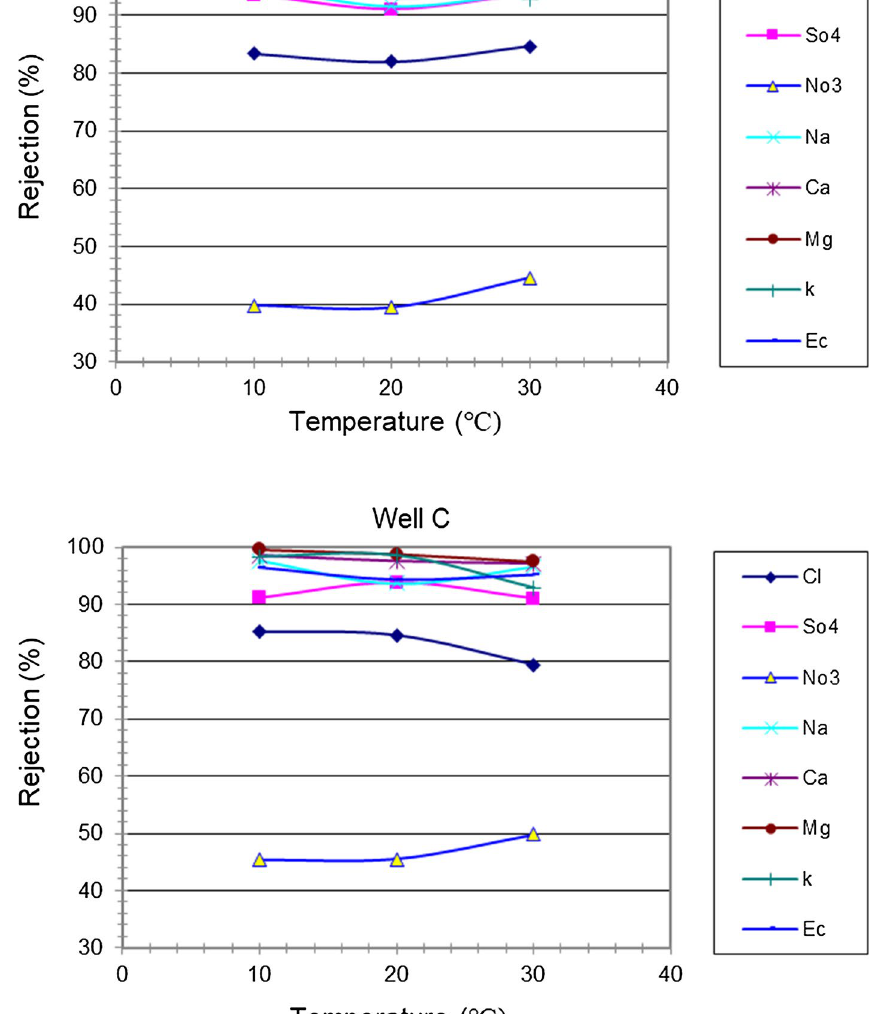
Fig. 11 Rejection rate of ions versus temperature (pressure: 4 bar)